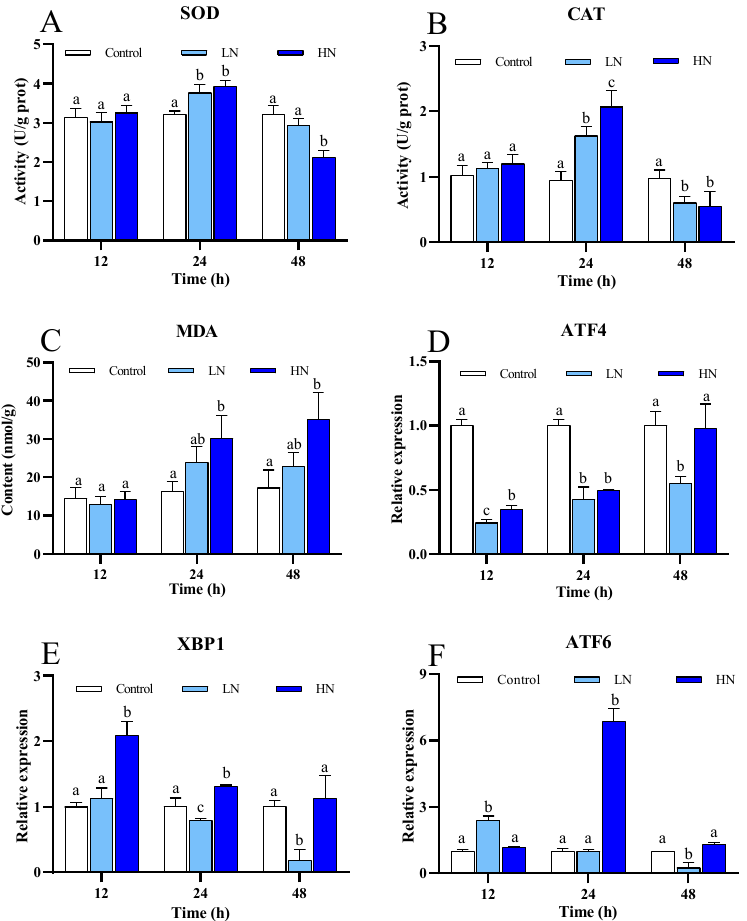
Figure 4. The enzyme activities of two antioxidant enzymes, the content of MDA and mRNA expression of three genes about ER stress of juvenile P. trituberculatus under nitrite stress. ( A ) The enzymes activities of SOD, ( B ) the enzyme activities of CAT, ( C ) the content of MDA, ( D ) mRNA expression of ATF4 , ( E ) mRNA expression of ATF6 , and ( F ) mRNA expression of XBP1 . At each time point, the letters indicate significant differences between experimental groups ( p < 0.05). (Figure 4F). ATF4 expression in both the nitrite-exposure groups was significantly